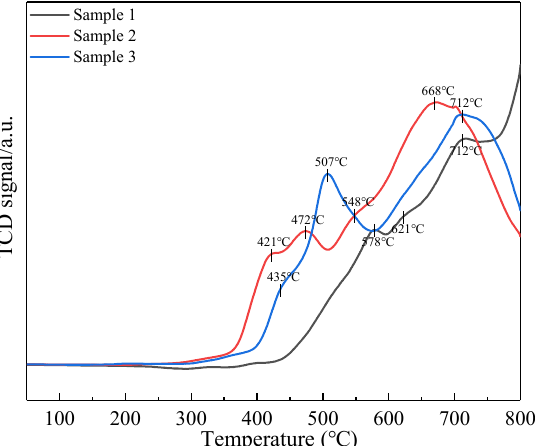
Figure 7. H 2 -TPR of the catalyst before and after modification.